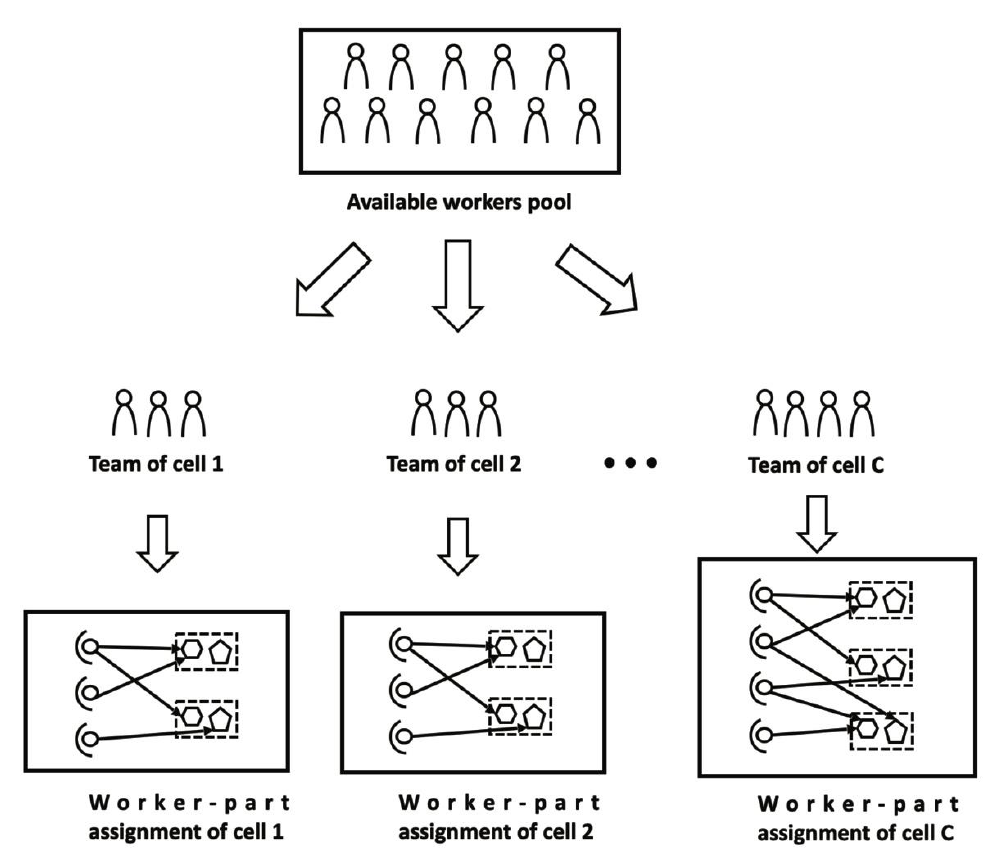
Figure 1. Illustration of TFWAP.